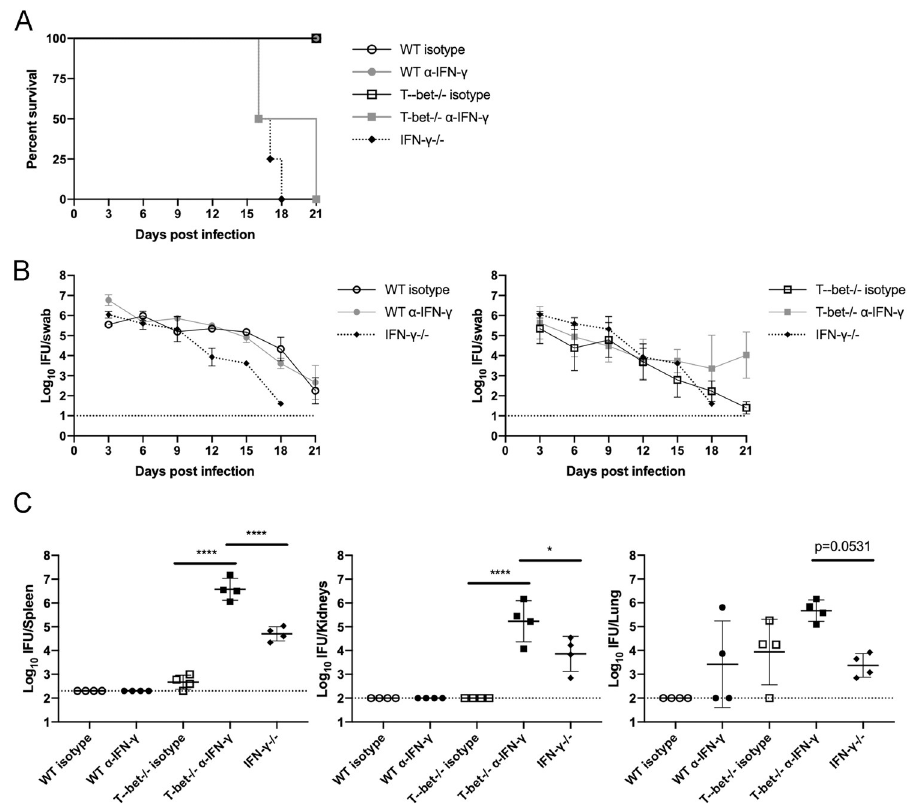
Fig 6. T-bet deficient mice given depleting α -IFN- γ are not able to control disseminated bacteria. Mice received 2.5mg Depo-Provera 7 days before infection with 1x10 5 IFU Chlamydia muridarum i.vag. (A) Survival curve. (B) IFU per vaginal swab over time of mice from (A) Data has been split into two graphs for ease of visualization. Results are shown as mean with SEM. (C) Bacterial load per organ at time of euthanasia (1-way ANOVA). All mice surviving in WT α -IFN- γ , WT isotype, and T-bet-/- groups were euthanized as controls despite showing no signs of disease at day 21 when the last mice in the T-bet-/- α -IFN- γ were euthanized. n = 4 for all groups (A-C). Data is from one